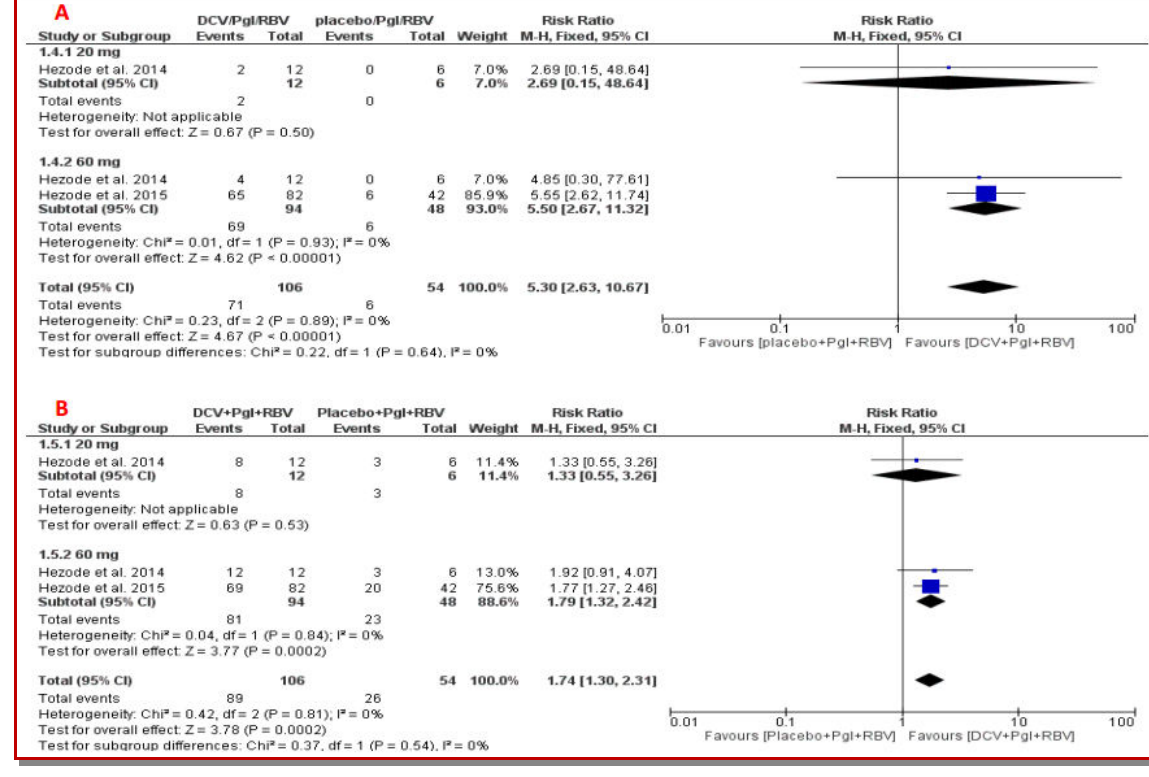
Figure 4: Forest plots comparing the dual and triple regimens in terms of extended rapid virologic response rate (A) and complete early virologic response rate